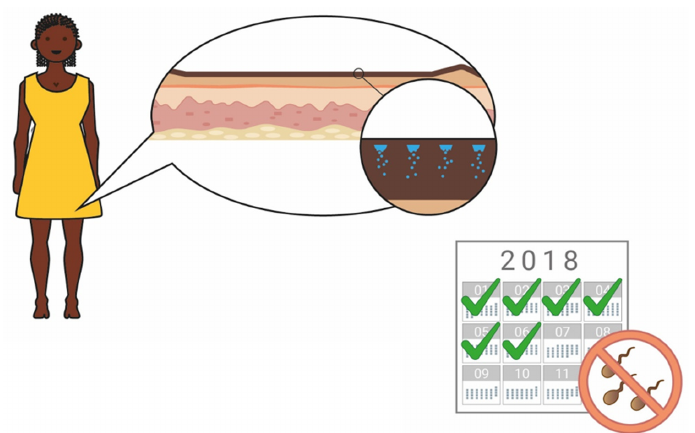
Figure 8. An illustration used to explain the concept to participants. The concept of a 6-month duration, reversible contraceptive based on biodegradable microneedles was explained to participants with the help of this